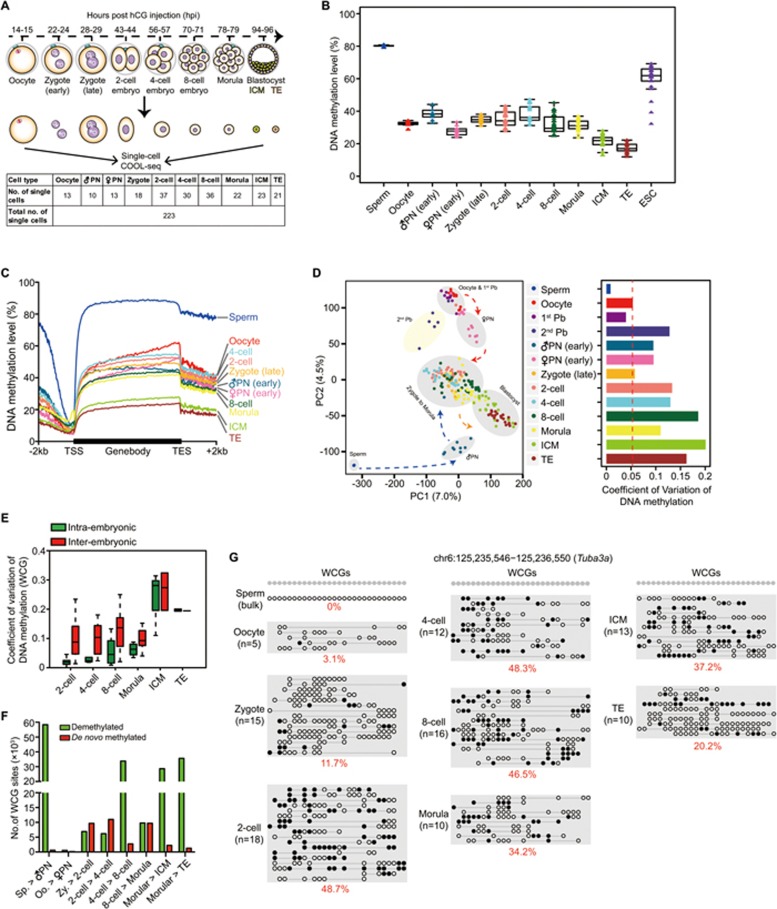
DNA methylation dynamics of mouse preimplantation embryos revealed by single-cell COOL-seq analysis. (A) Numbers of individual oocytes and blastomeres analyzed using the single-cell COOL-seq technique. Note that all the samples in the relevant stages used in this study were carefully examined to remove contaminated polar bodies. (B) Boxplot of average DNA methylation level in each single blastomere. The mean methylation level of all the detected WCG sites (≥ 2× depth) in a single cell was calculated (shown as a triangle), and cells at the same developmental stage were plotted together in the same box. The bottom and top of the boxes indicate the first and third quartiles, respectively, and the lines inside the boxes indicate the medians of the data. Note that the sperm DNA data were from bulk samples. (C) The average DNA methylation levels (WCG methylation level) along the gene bodies, 2 kb upstream of the TSS and 2 kb downstream of the transcription end sites (TES) of all the RefSeq genes across different developmental stages. (D) Principle component analysis of the DNA methylome (methylation levels of WCG sites in 5 kb windows) of the gametes, polar bodies, pronuclei and cleavage stage embryos (222 single cells and 9 bulk sperm samples). Right panel represents the coefficient of variance of DNA methylation within each stage. (E) Coefficient of variation (CV) of DNA methylation among single blastomeres. (F) Number of demethylated and de novo methylated WCG sites after fertilization. A WCG site with an over 0.75 methylation level at one developmental stage and with an at least 0.3 methylation level decreases at the following stage was defined as a demethylated WCG site (Benjamini-Hochberg's FDR < 0.05). A WCG site with < 0.25 methylation level at one developmental stage and with an at least 0.3 methylation level increases at the next stage was defined as a de novo methylated WCG site (Benjamini-Hochberg's FDR < 0.05). (G) Representative de novo methylated locus in early mouse embryos. The open white and filled black circles indicate the unmethylated and methylated WCG sites, respectively. The circles on the same line indicate the DNA methylation state in one single cell. Note that the DNA methylation state in the bulk sperm sample was the mean methylation state at each WCG sites.